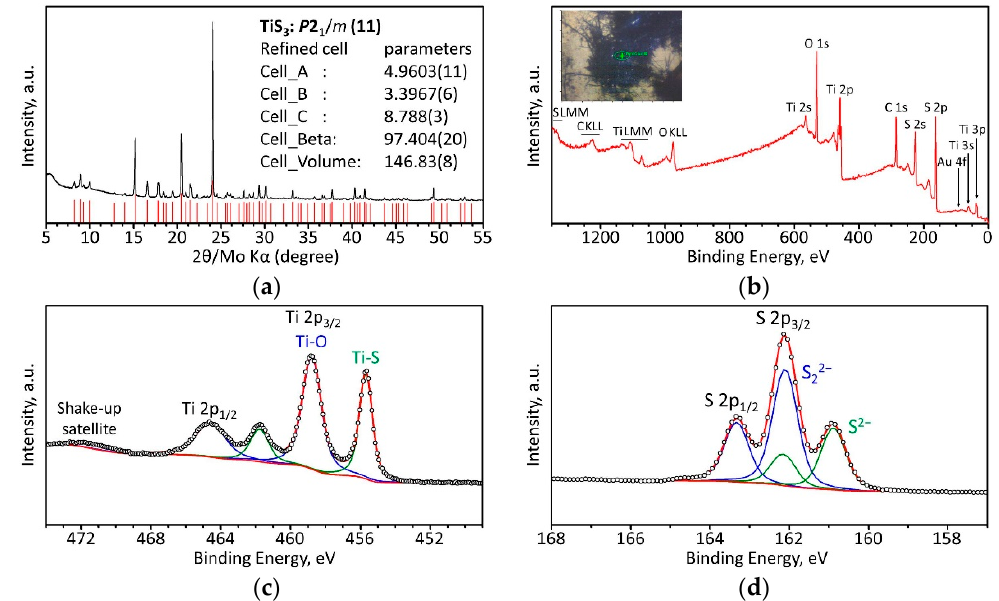
Figure 3. Characterization of TiS 3 NWs by means of XRD and XPS techniques. ( a ) XRD pattern of a TiS 3 powder. ( b ) XPS survey spectrum taken on the TiS 3 material deposited on an Au-coated Si substrate. The absence of Au-related photoelectron peaks confirms the high density of TiS 3 NWs on the substrate, as can be seen in the optical photograph in the inset (black needles are TiS 3 NWs on an Au-coated Si substrate, green spot shows the area where the XPS spectra were recorded). ( c ) Ti 2p and ( d ) S 2p XPS spectra of TiS 3 NWs. In panels ( c , d ), the open circles are the experimental data, the red curves are the respective envelopes of all peaks, and the green and blue curves are the fitted doublets of the assigned components.